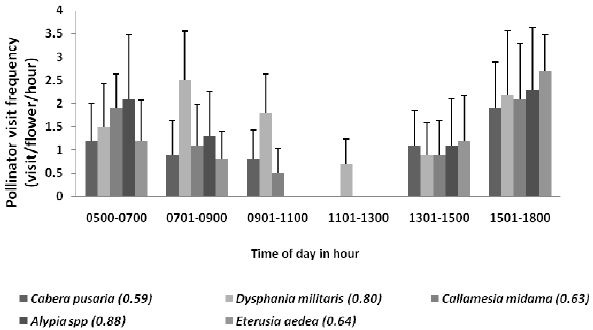
Fig. 3. Frequency of pollinators (moths) visitation in respect to the time of day for S. wallichii in the year 2013 (values in parentheses indicate LSD values for 5%) (7 species of moth or butterfly) and Coleoptera (1 species